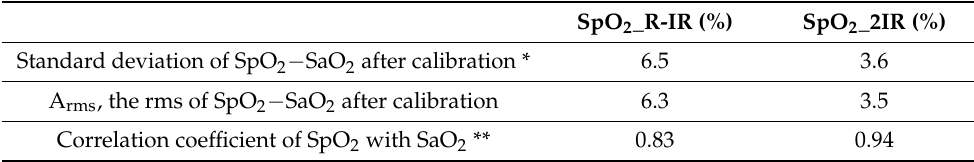
Table 2. Comparison of SpO 2 _2IR or SpO 2 _R-IR versus SaO 2 . SpO 2 _R-IR (%) SpO 2 _2IR (%) Standard deviation of SpO 2 − SaO 2 after calibration * 6.5 3.6 A rms , the rms of SpO 2 − SaO 2 after calibration 6.3 3.5 Correlation coefficient of SpO 2 with SaO 2 ** 0.83